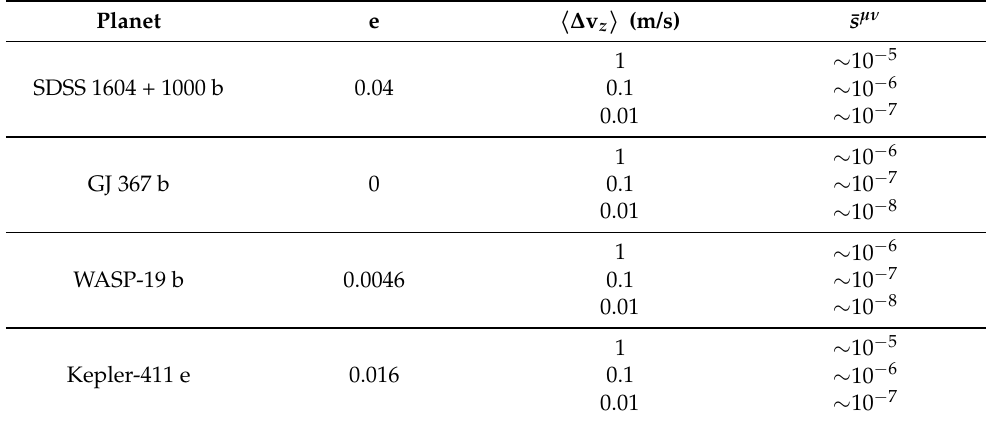
Table 1. Estimates for ¯ s µν for exoplanets with small eccentricity. The parameters to be used in Formulas (30)–(32) can be found at http://exoplanet.eu, accessed on 7 November 2022. Planet e (cid:104) ∆ v z (cid:105) (m/s) ¯ s µν SDSS 1604 + 1000 b